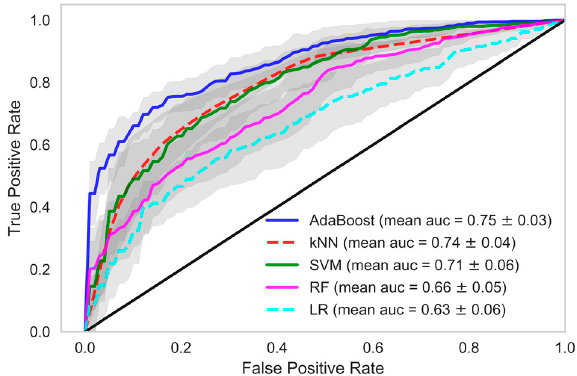
Figure 6. Receiver Operating Characteristics plot showing mean area under curve of all the classifiers of Model 2 when the 15 recent HD sessions were considered.